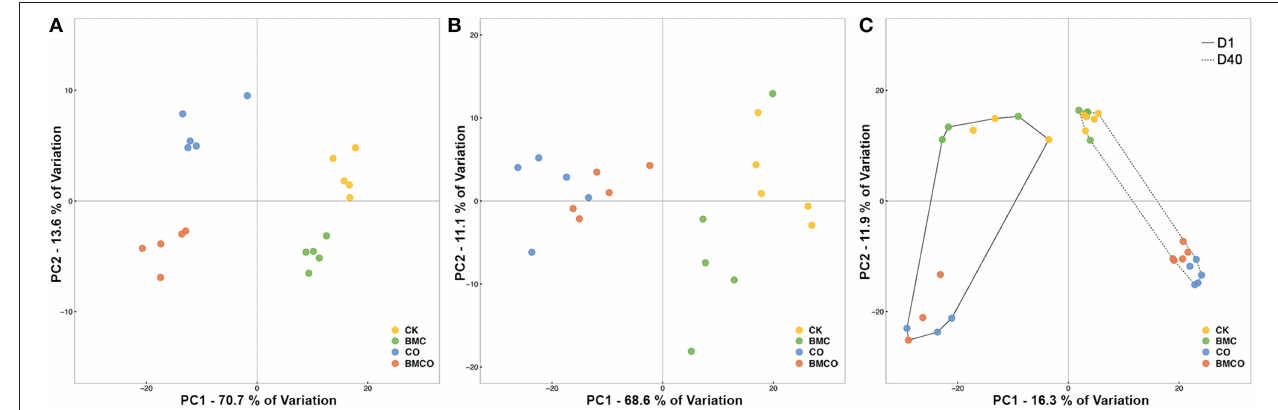
FIGURE 1 | Unconstrained principal coordinates analysis (PCoA) plots illustrating the similarities in individual samples based on: (A) Euclidean distances of edaphic variables, (B) Euclidean distance of plant variables, (C) Bray–Curtis distance of bacterial communities. Edaphic and plant variables were normalized before calculating the Euclidean distance. Relative abundance of bacterial communities was square root transformed before calculating the Bray–Curtis distance.